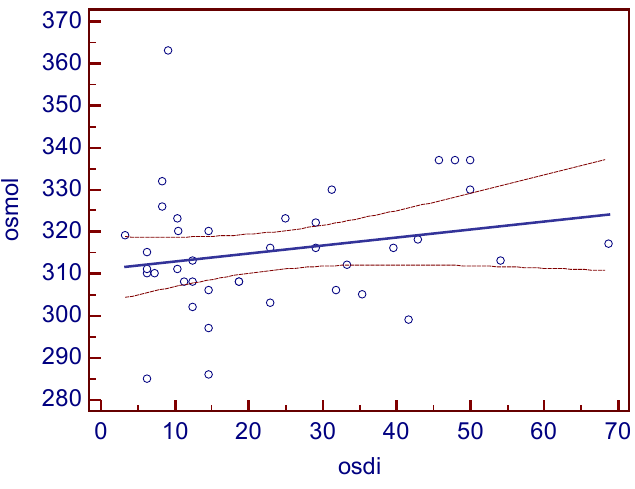
Figure 2 . A scatter plot of tear osmolarity (osmol) versus OSDI score (osdi) is shown. Included is the linear regression line (solid blue line) with its associated 95% confidence interval (dotted red line), ( r = 0.22 p = 0.17).